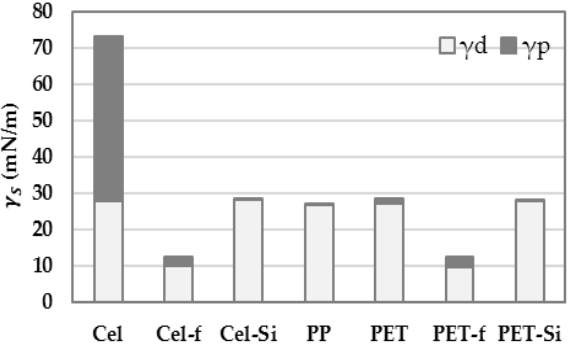
Figure 1. Surface energy components of solid surfaces.